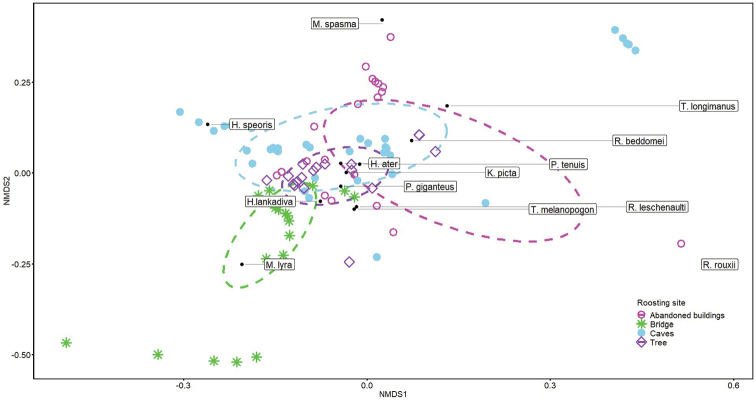
NMDS Ordination of Bat association with different roosting sites in Maduru-Oya National Park periphery. The ellipses represent 95% confident intervals around the centroids. Cynopterussphinx and Phoniscuscf.jagorii, which were only recorded as dead specimens, were not included in the ordination.